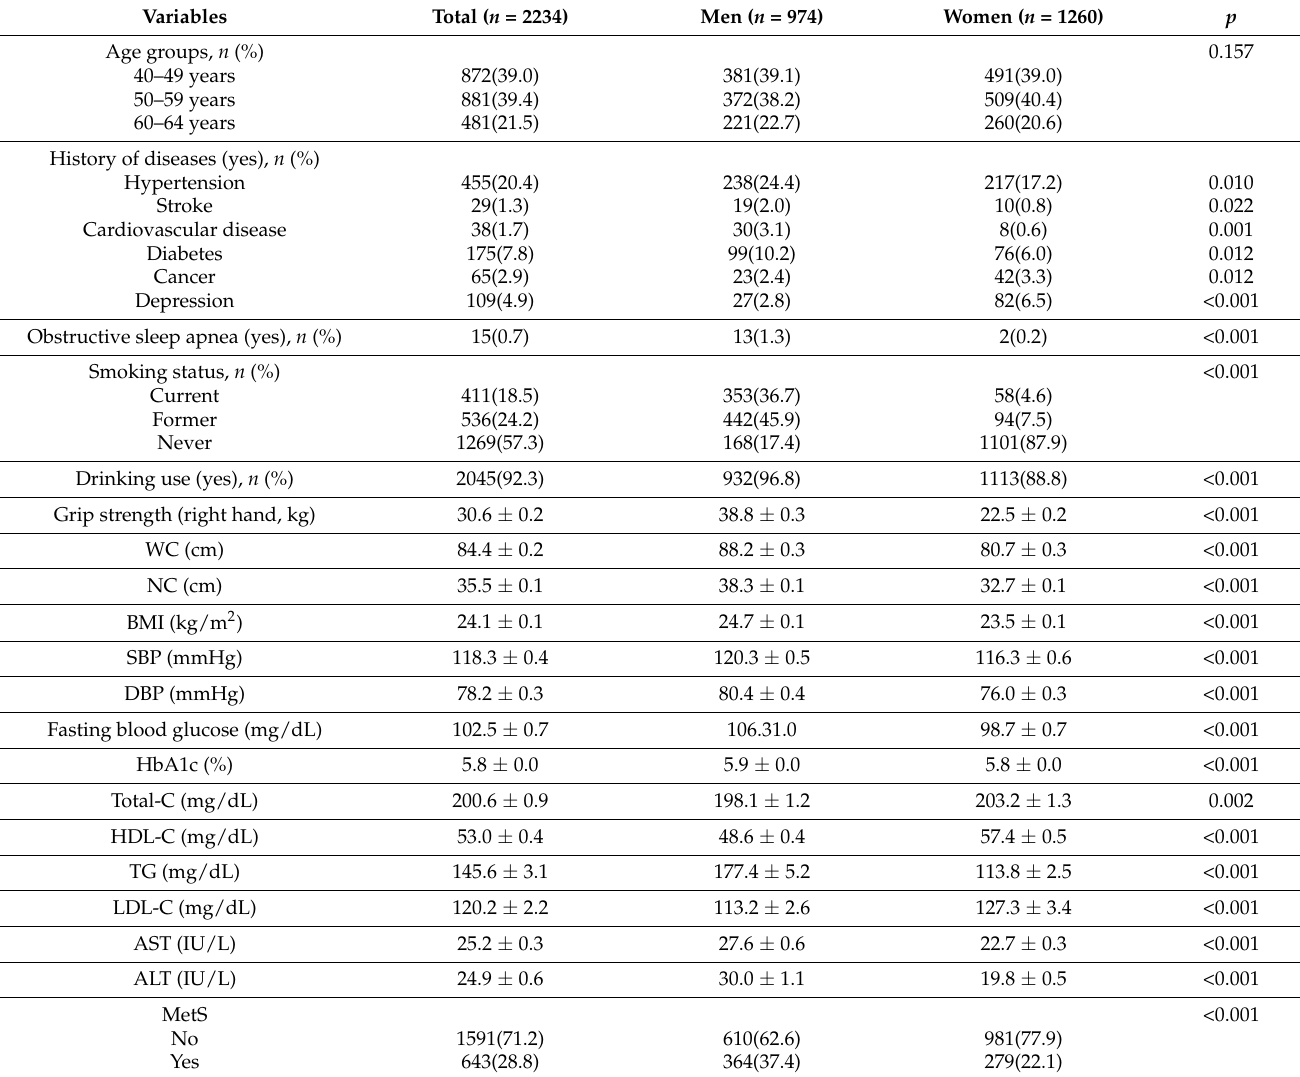
Table 2. Demographic and biochemical characteristics of the participants according to